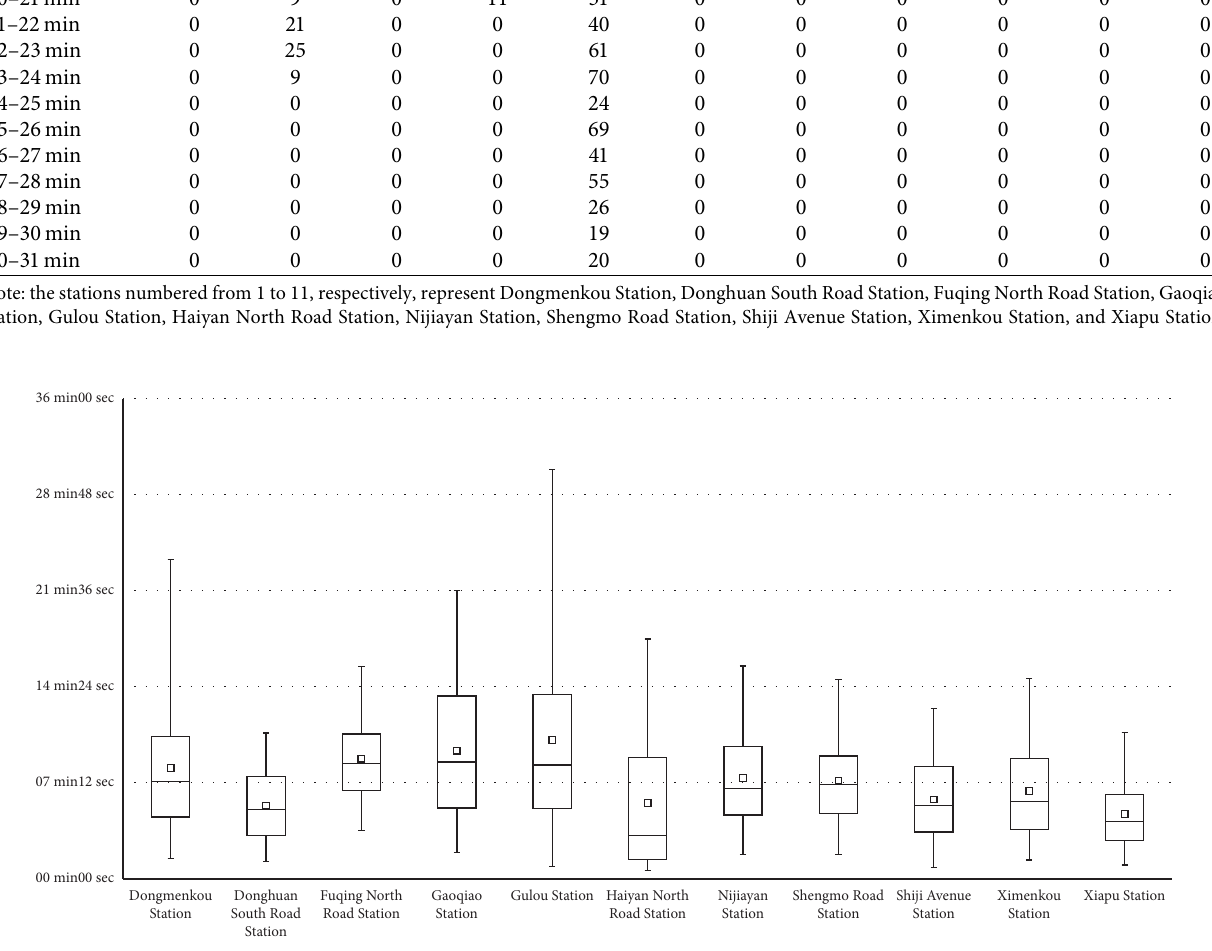
Figure 5: Box plot of transfer